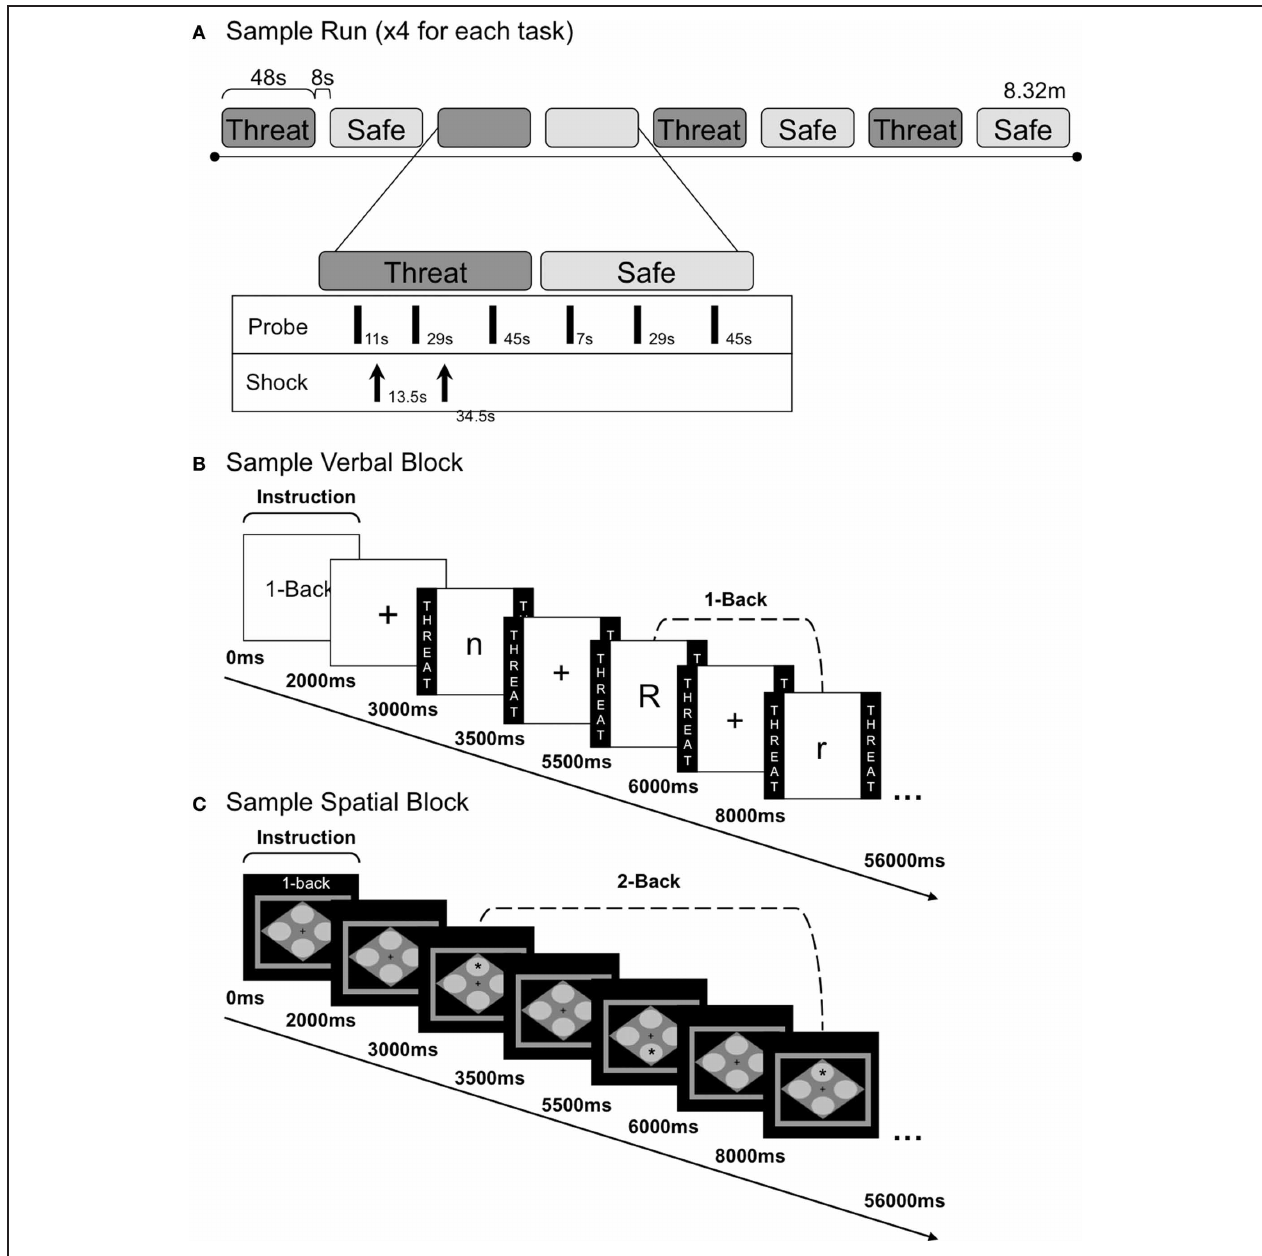
FIGURE 1 | Task run and block structure. (A) Schematic diagram of a sample run with alternating threat and safe n -back blocks. During each n -back block, three acoustic probes were delivered. Shocks were delivered three times during each run (with 0–2 shocks each threat block). (B) Sample verbal 1-back block and internal trial structure. Each block began with an instruction screen, followed by a fixation cross. Eighteen letters were presented in succession during each block, separated by a 2s ITI (fixation). Participants made a keyboard button press response for every letter presented; one